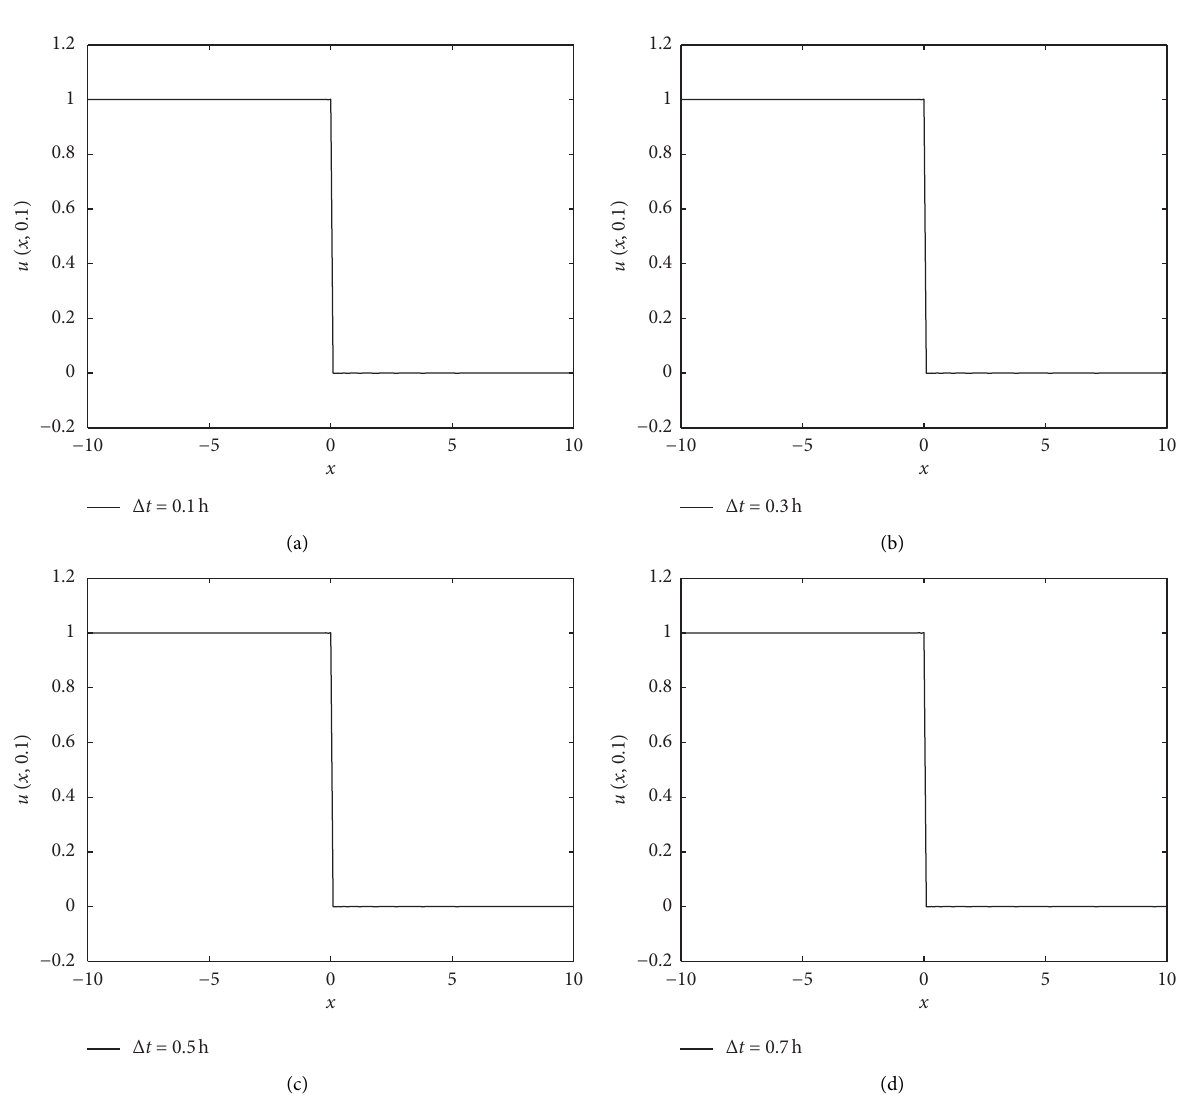
Figure 5: The numerical solutions of Example 3 with α � 0 . 9and N � 200 and for different CFL numbers at T � 0 . 1. (a) σ � 0 . 1, (b) σ � 0 . 3, (c) σ � 0 . 5, and (d) σ � 0 .